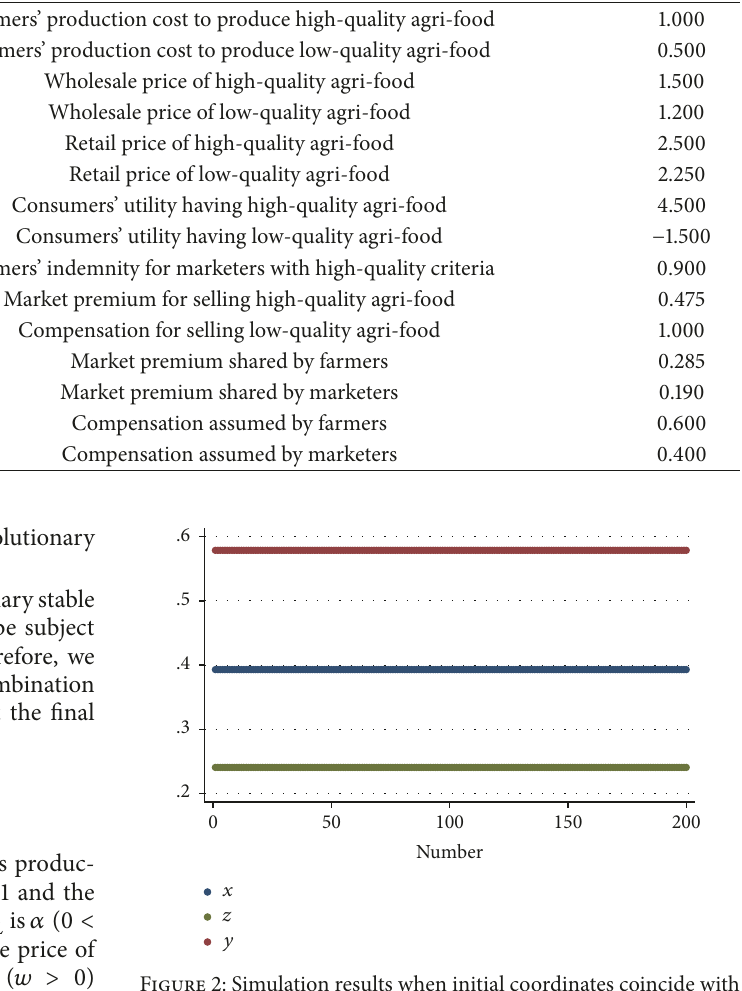
Figure 2: Simulation results when initial coordinates coincide with the saddle